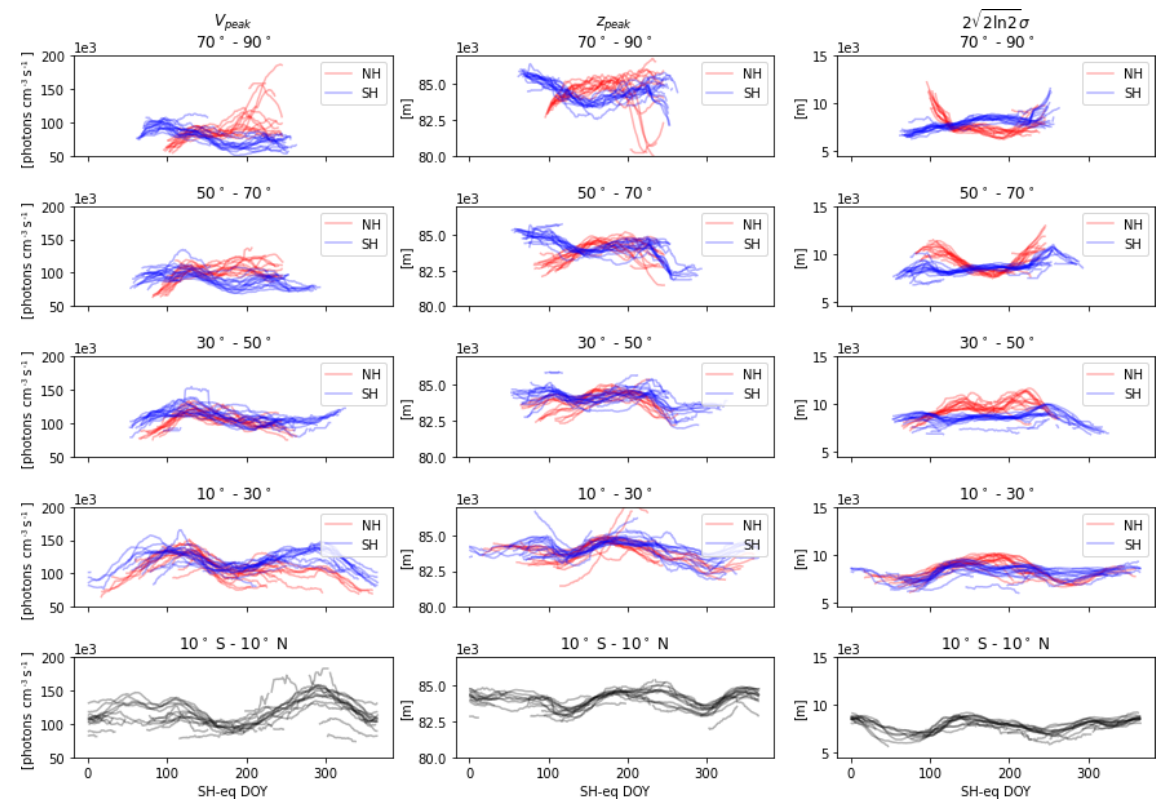
Figure 9. Zonal average monthly running means of the airglow peak intensity (first column), peak height (second column) and layer thickness (third column). Each line represents 1 year of data binned in 20 ◦ latitude bins (see the top of each panel for labels). Note that the Northern Hemisphere (NH) plots (in red) are shifted by 180d in order to centre the winter periods to those of the Southern Hemisphere (SH; in blue) and the tropics (in black, bottom row); thus, the horizontal scale is labelled as the SH equivalent (SH-eq.) day of the year